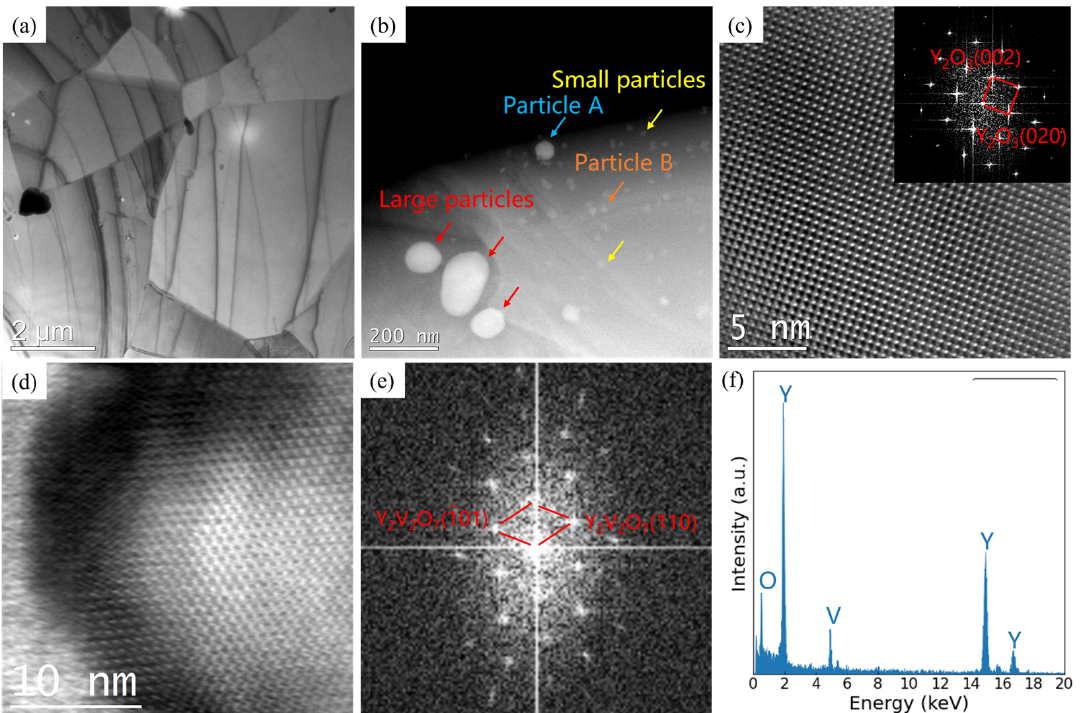
Figure 2. TEM images and corresponding EDS analysis of V-based alloys: ( a ) TEM image of V-4Cr-4Ti alloy; ( b ) STEM image of V-4Cr-4Ti-2Y alloy; ( c ) HRTEM image of Particle A (an example of large particle) and corresponding FFT image; ( d ) HRTEM image of Particle B (an example of small particle); ( e ) FFT image of ( d ); ( f ) EDS result of Particle A.